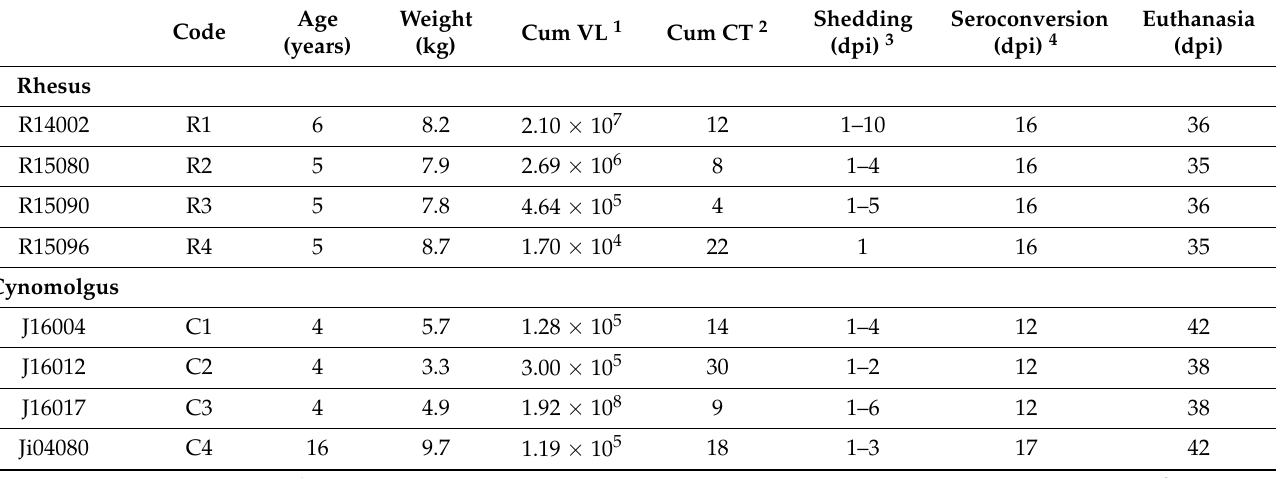
Table 1. Animals used in the